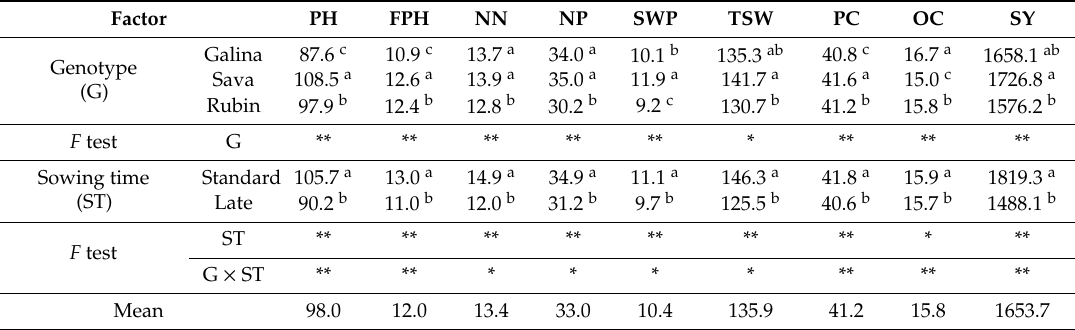
Table 2. Genotype and sowing time e ff ects on the quantitative and quality traits in 2017. Factor PH